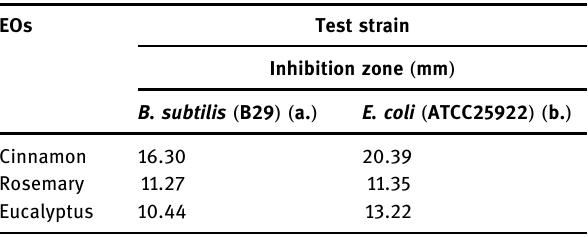
Table 3: Data of inhibition zone for 3 EOs against B. subtilis